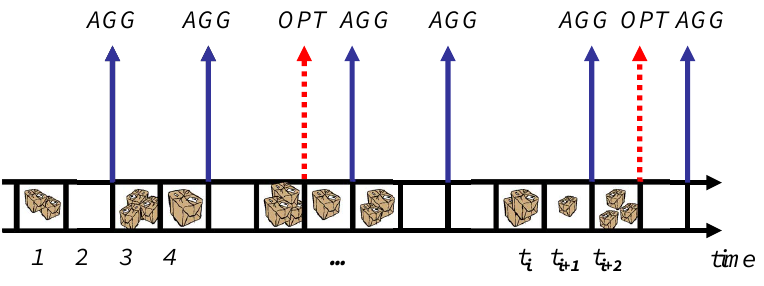
Fig. 2: Illustration of a sequence of event arrivals at a leaf and the corresponding forwarding actions of the online algorithm KNR for c = 4 . In addition, the time slots where the optimal offline algorithm forwards its messages are marked as well. Note that we cannot verify in this limited view of a leaf node how much better OPT ’s decisions are because of our lack of knowledge on the situation at the other